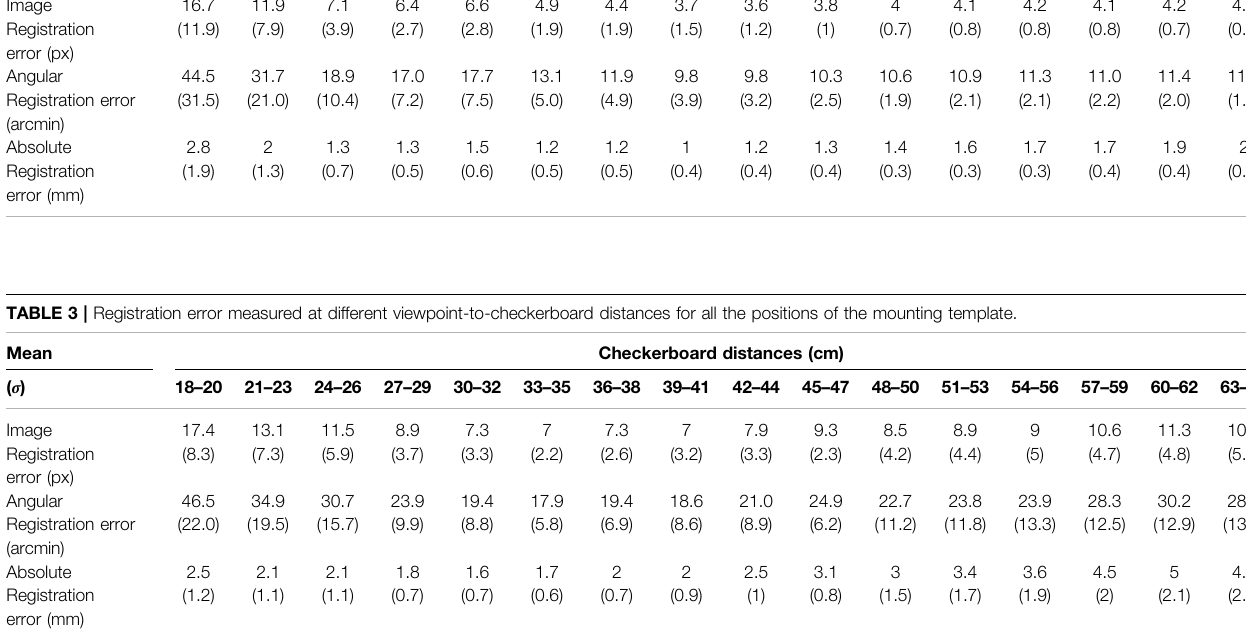
TABLE 2 | Registration error measured at different viewpoint-to-checkerboard distances for the calibration position. Mean Checkerboard distances (cm) ( σ ) Image